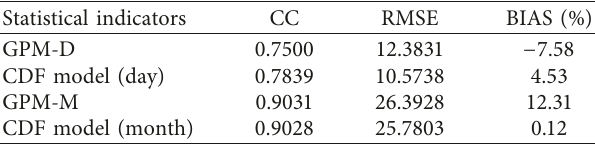
Figure 7: CDF curves for gauge, GPM, and GPM-CDF datasets. (a) Day; (b) month. Table 5: Comparison of the CDF model results.